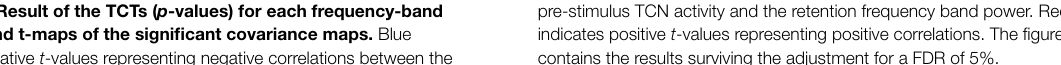
FIGURE 4 | Result of the TCTs ( p -values) for each frequency-band and TCN, and t-maps of the significant covariance maps. Blue indicates negative t -values representing negative correlations between the